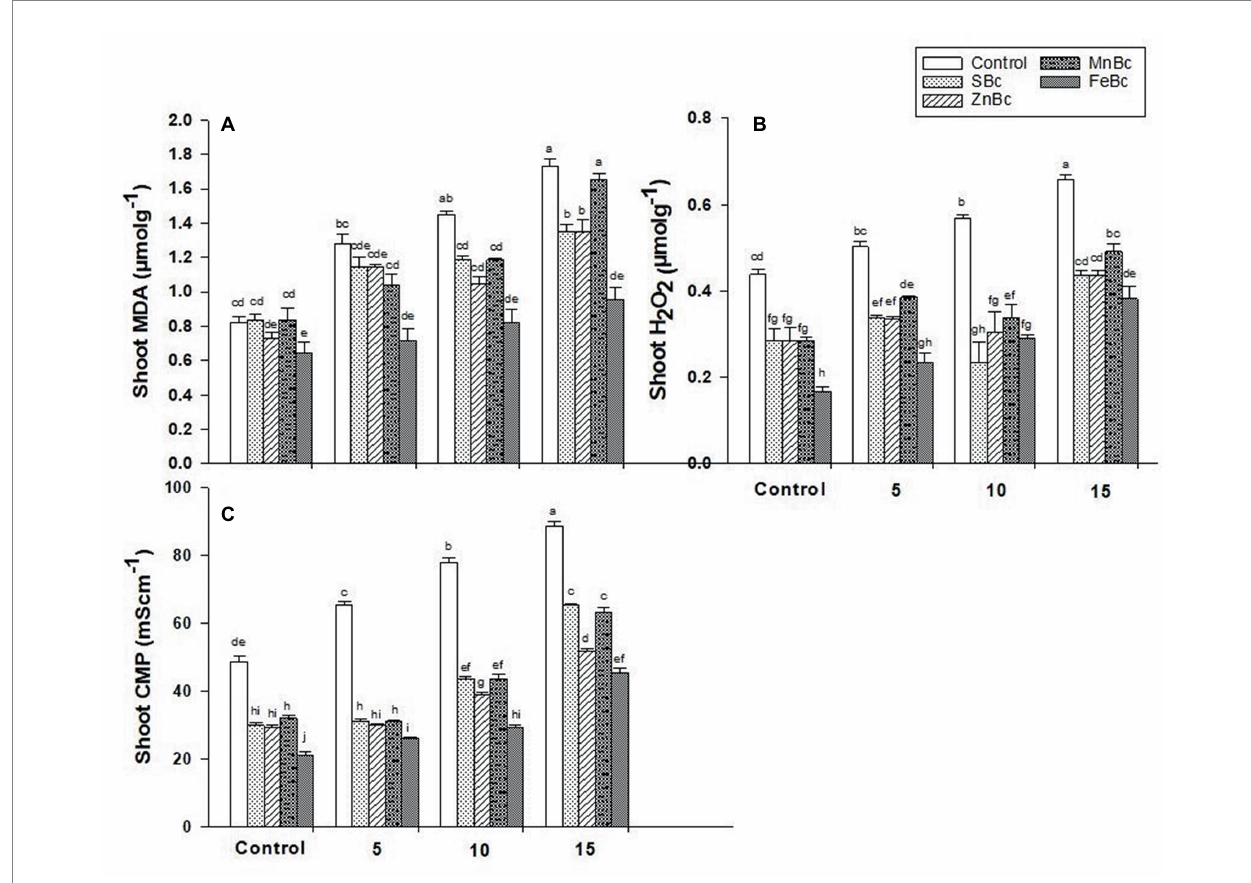
FIGURE 4 Concentrations of (A) Shoot MDA, (B) Shoot H 2 O 2 and (C) Shoot CMP of T. aestivum L. grown under various treatments such as T1 = DW, T2 = DW + 0.1% SBc, T3 = DW + 0.1% ZnBc, T4 = DW + 0.1% MnBc, T5 = DW + 0.1% FeBc, T6 = 5dSm − 1 BW, T7 = 5dSm − 1 BW + 0.1% SBc, T8 = 5dSm − 1 BW + 0.1% ZnBc, T9 = 5dSm −